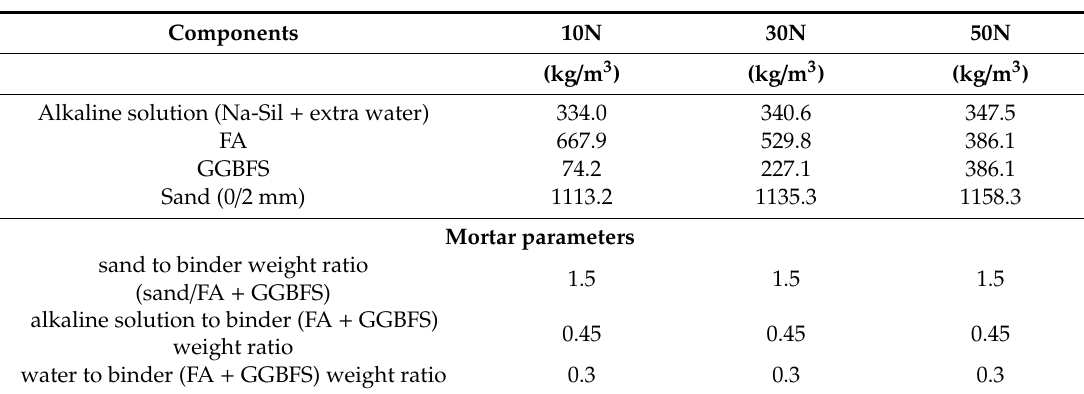
Table 6. Mix compositions of geopolymer mortars 10N, 30N and 50N for 1 m 3 of